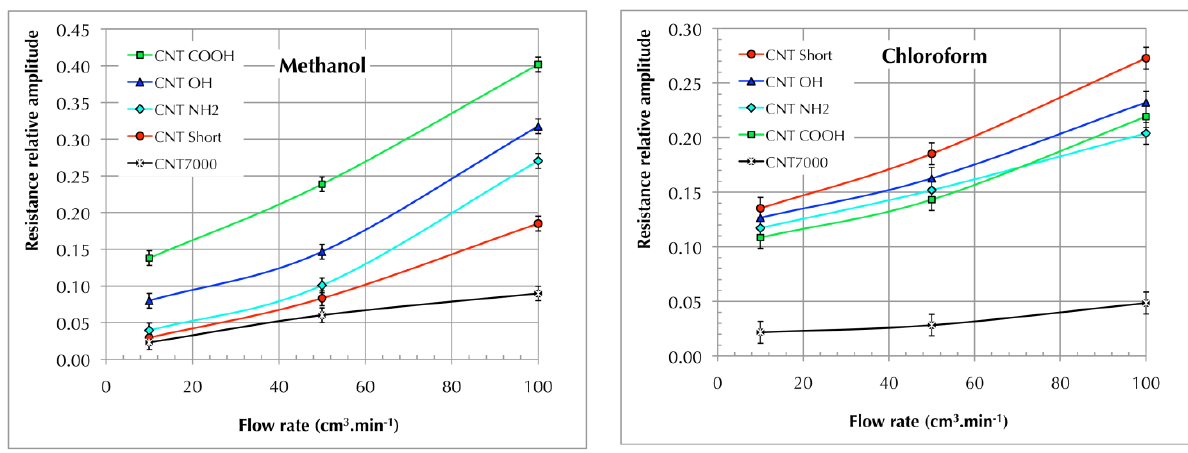
Figure 5. Quantitativity of the signals of the CNT sensors when exposed to methanol ( left ) and chloroform ( right ) at different vapor flow rates (the effects of the amount of